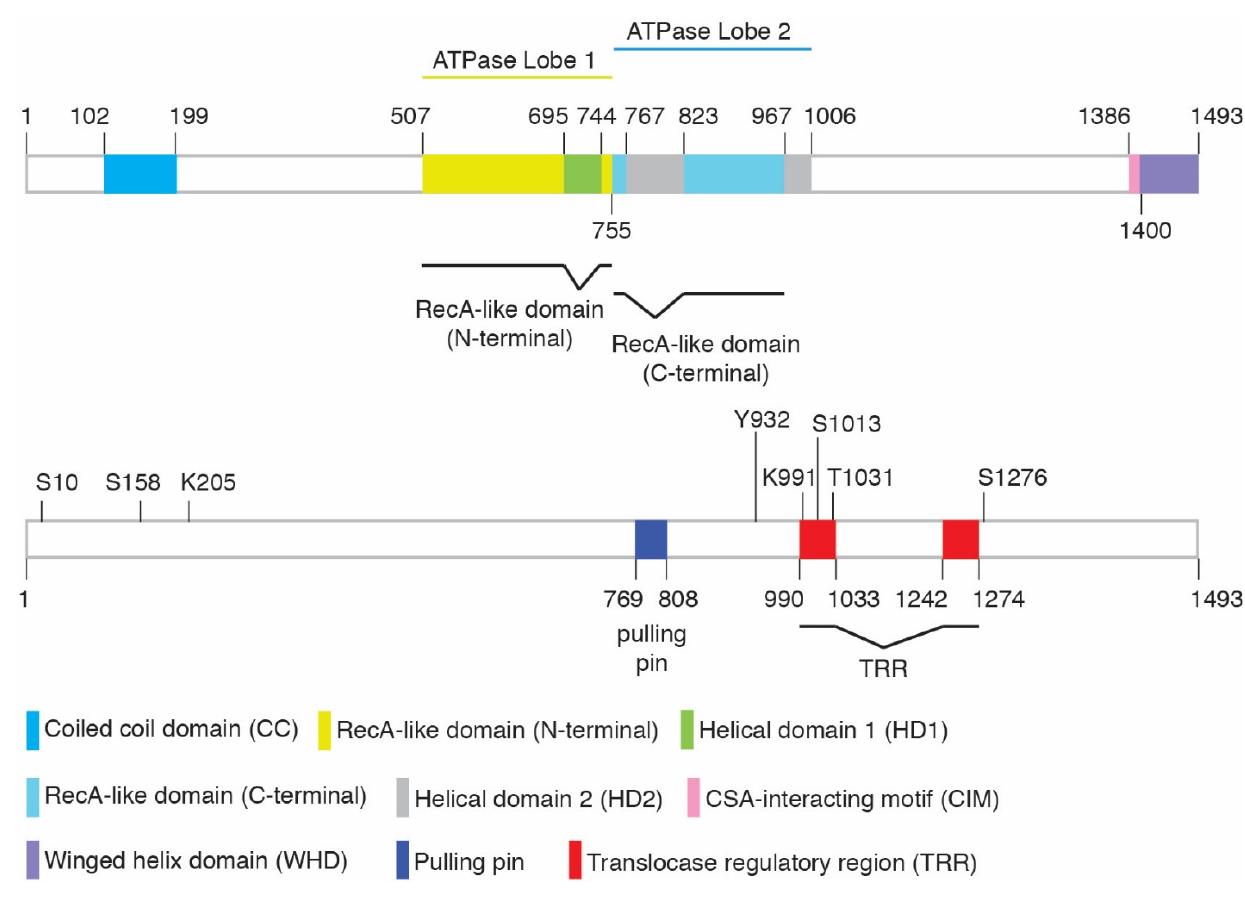
Figure 1. Schematic diagram of CSB.